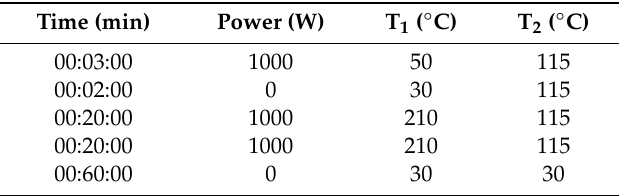
Table 4. Details of the microwave digestion